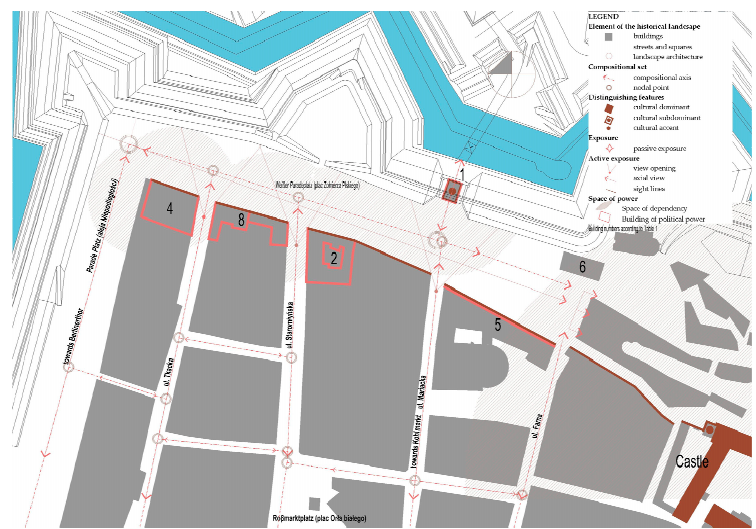
Figure 7. Landscape analysis of plac ˙Zołnierza Polskiego in 1750. Plac ˙Zołnierza Polskiego was located between the northern line of the modern fortifications and the medieval perimeter blocks which form a sight line. The main compositional axis of the complex stretched along an east-west line, at the same time creating an axial view. In the western part of the square, the axis formed a nodal point with the main axis of the composition of plac Niepodległo´sci. From the east, the square had a view onto the Oder valley. The dominant form of the square was the space of authority, including the buildings of the royal administration, state authority and military authority (1, 2, 4, 8). The main entrance to the city led through the King’s Gate (1), a subdominant located on the axis of ul. Mariacka. As a symbol of royal rule and domination over the city, the Gate was equipped with rich, symbolic sculptural decorations. The dominant feature in the northern spatial structure of Szczecin was the Pomeranian Duces’ Castle, with an accent in the form of the Bell Tower (source: created by